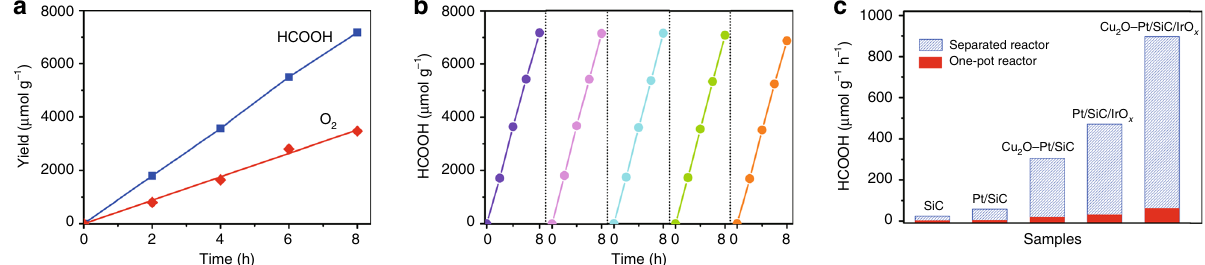
Fig. 6 Photocatalytic performance of CO 2 reduction with H 2 O. a Evolutions of HCOOH and O 2 as a function of illumination time and b cycle experiment of HCOOH evolution in the spatially separated reaction system with Cu 2 O – Pt/SiC/IrO x as the reduction side photocatalyst. c Comparison for the HCOOH evolution between in the spatially separated reaction system and in the conventional one-pot reactor with different samples as the reduction side